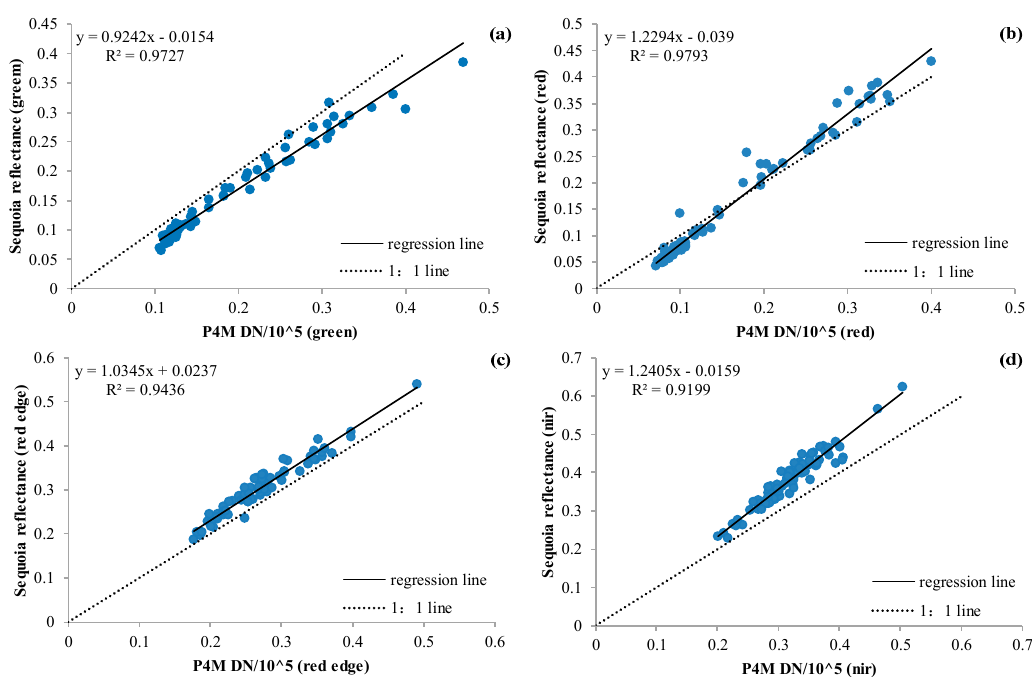
Figure 8. Scatter plots of Sequoia and P4M spectral values (10 cm) in the green band ( a ), red band ( b ), red edge band ( c ) and near infrared band ( d ).